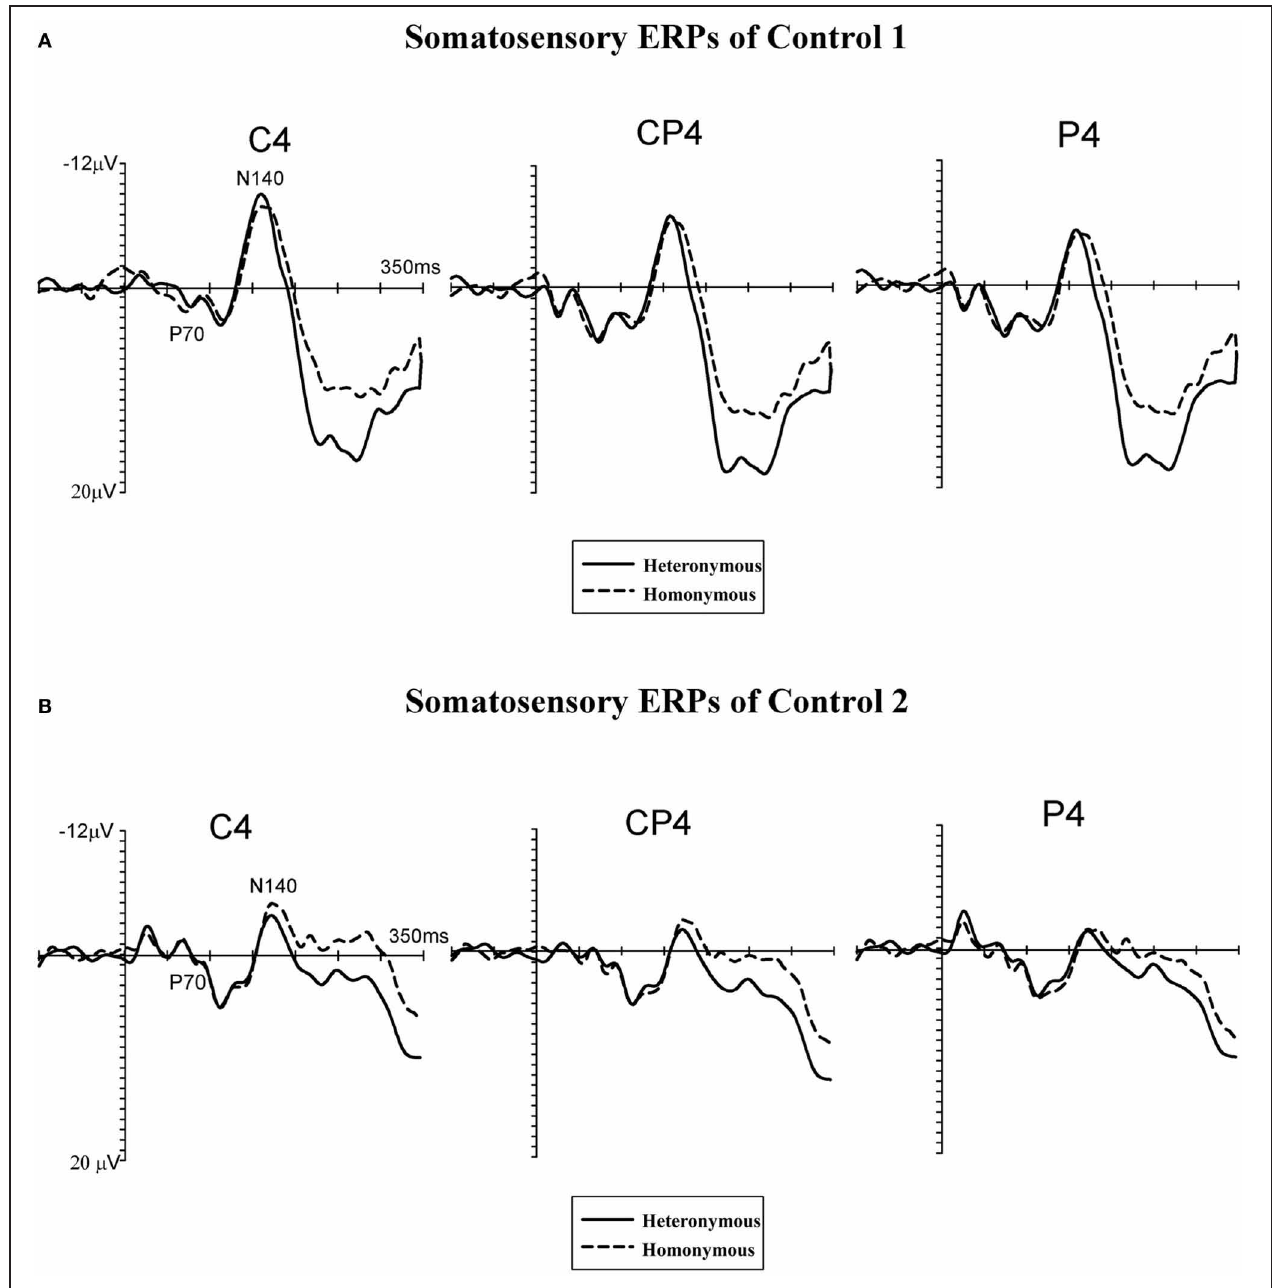
FIGURE 5 | Grand-averaged somatosensory ERP waveforms of two neurologically unimpaired participants (A,B). Tactile stimuli were delivered to the left hand while this hand was placed in the right, heteronymous hemi-space ( solid lines ) and in the left, homonymous